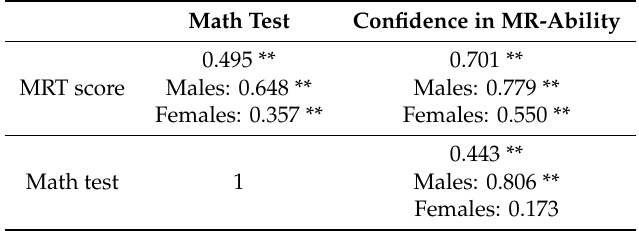
Table 1. Correlations of MRT score, math-test performance, and confidence in mental rotation ability (MR-Ability) for all participants and for males and females separately.